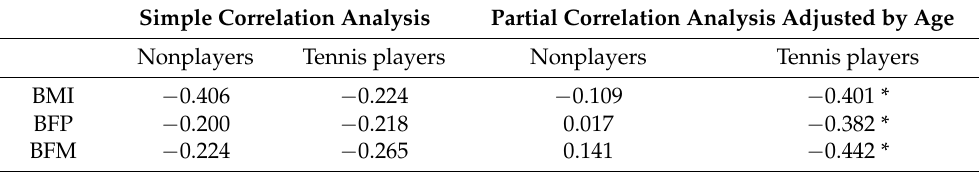
Table 3. Correlations between the FMD and the body composition parameters. Simple Correlation Analysis Partial Correlation Analysis Adjusted by Age Tennis players Tennis players